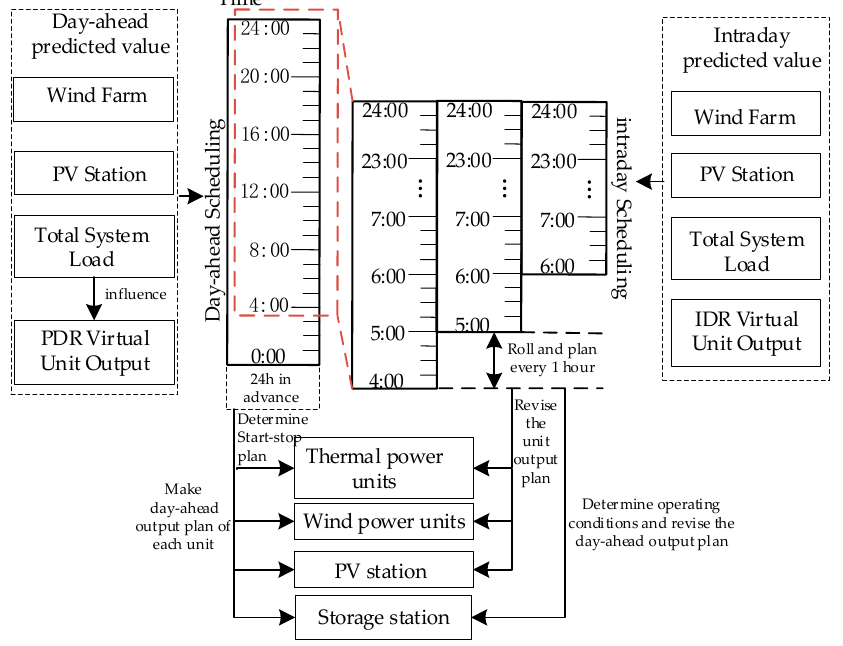
Figure 1. Wind-PV-thermal-storage scheduling mode considering demand response.